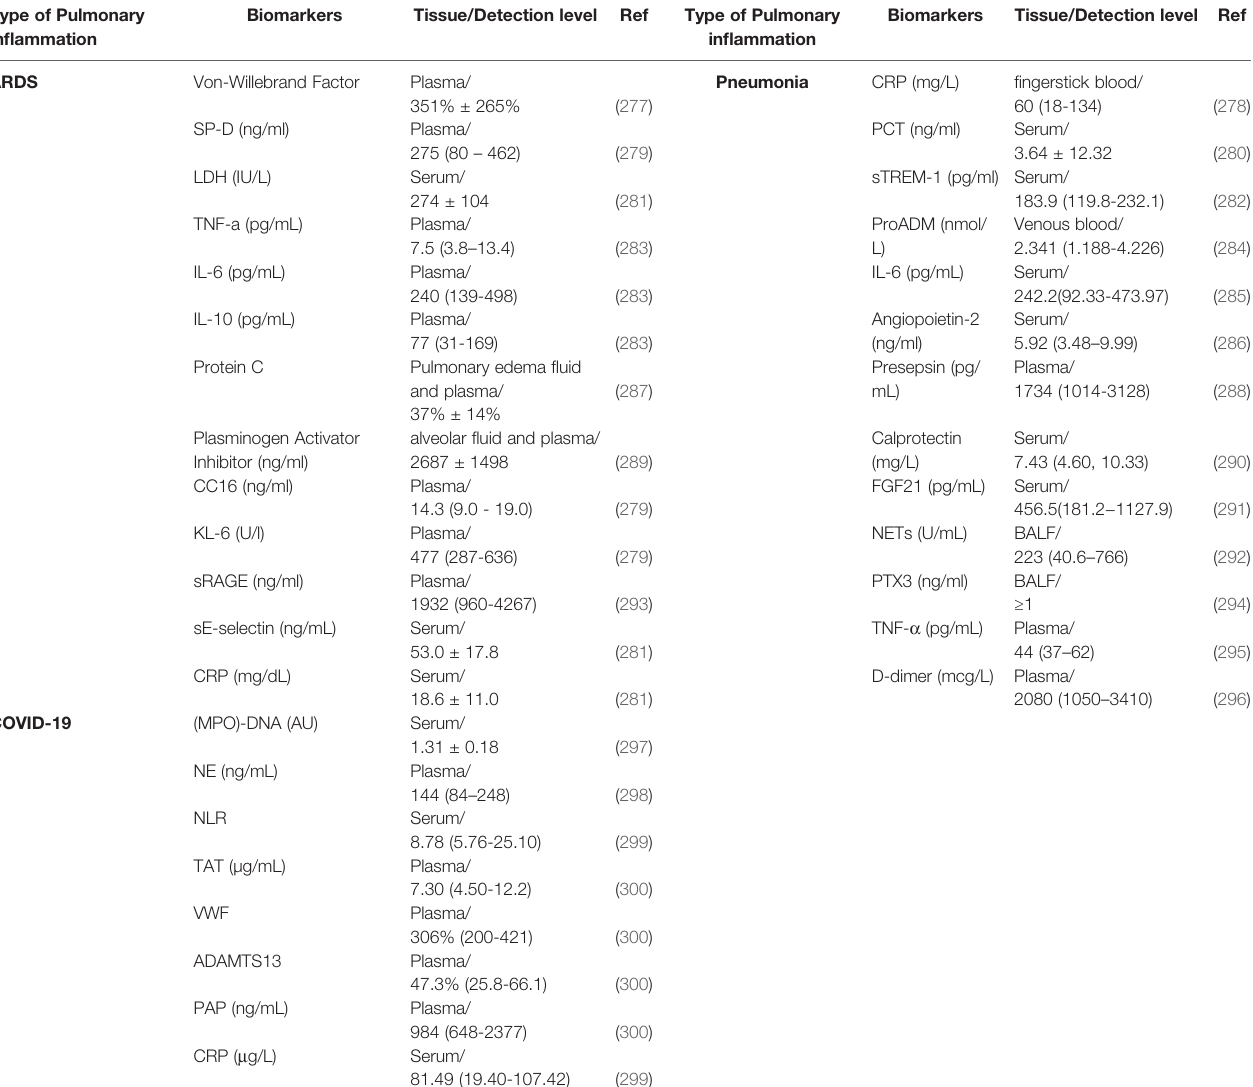
TABLE 3 | Neutrophilic biomarkers of pulmonary in fl